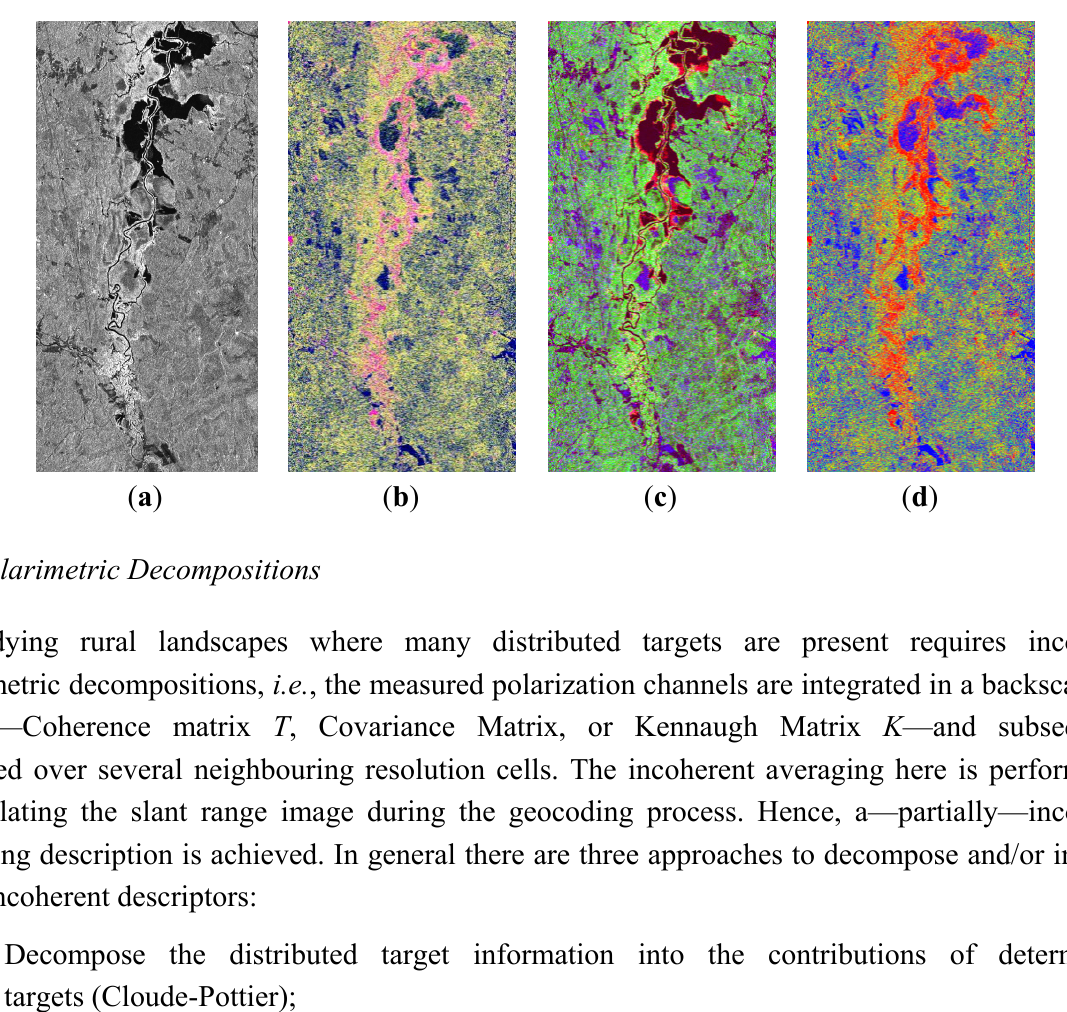
; ( b ) Cloude-Pottier RGB: 0